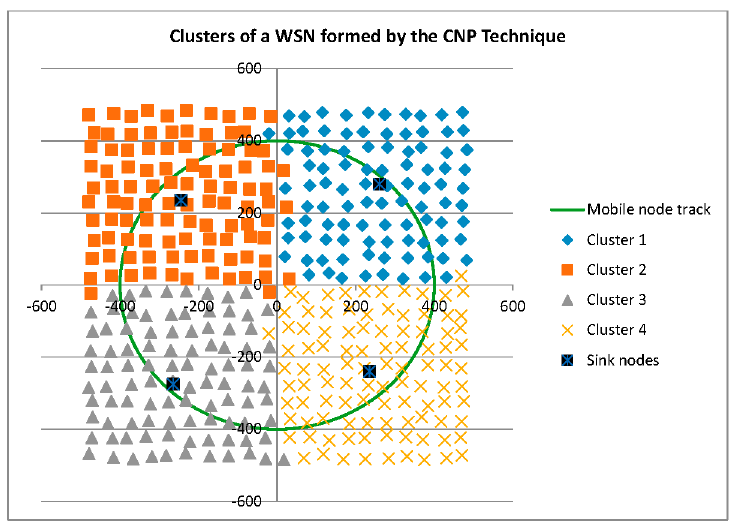
Figure 4. Clusters formed by the Dynamic technique.